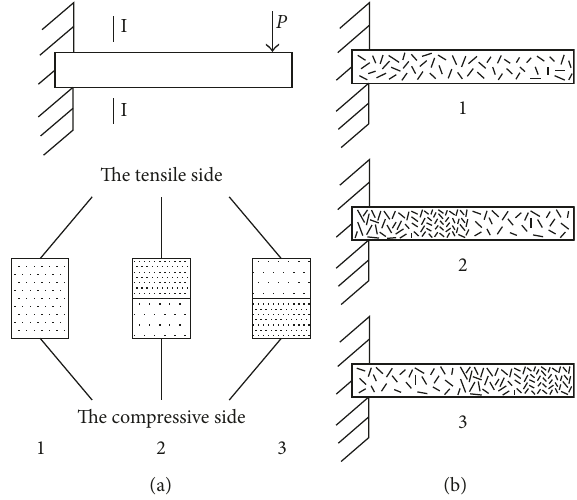
Figure 11: Different distribution patterns of steel fibre in concrete cantilever beams. (a) Different fibre distributions in I cross section. (b) Different longitudinal fibre